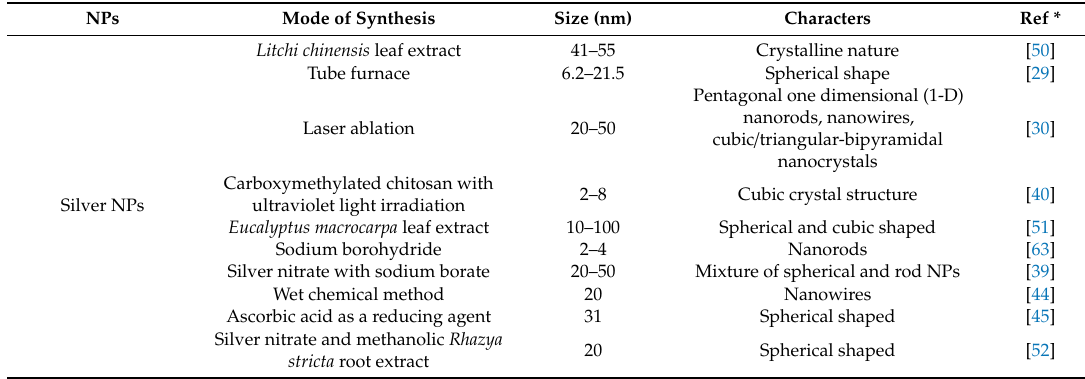
Table 1. Mode of synthesis and characteristics of commercially important nanoparticles